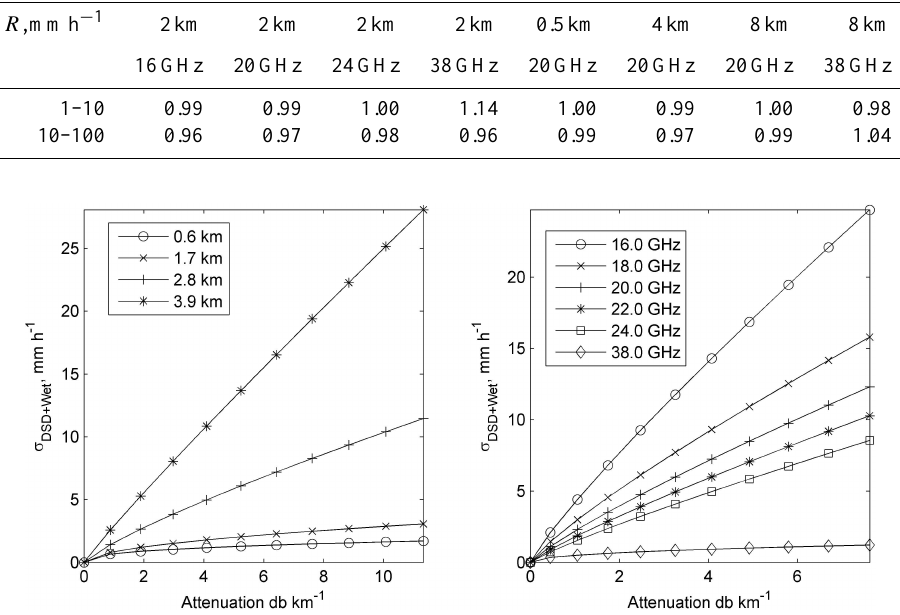
Fig. 5. The predicted RMSE of rain rate estimates ˆ σ DSD + Wet (R L | A R + n w ) (Eq. 11) as a function of link length for a 22GHz vertically- polarized link (left) and as a function of link frequency for a 2.2km link